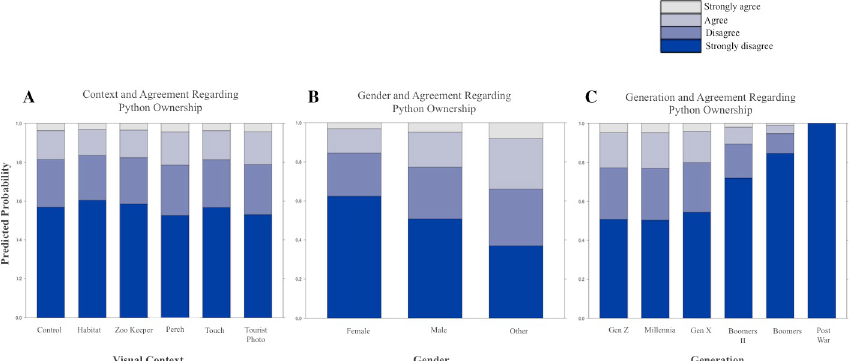
Fig 3. A-C. Predictor Effect Plots Showing the Role of Each Predictor on Interest in Python Ownership. Predictor effect plots provide graphical summaries for fitted regression models by averaging and conditioning the other predictor variables to summarize the role of a selected focal predictor in a fitted regression model (Fox & Weisberg, 2019). (Note: Figures sized to span two columns).